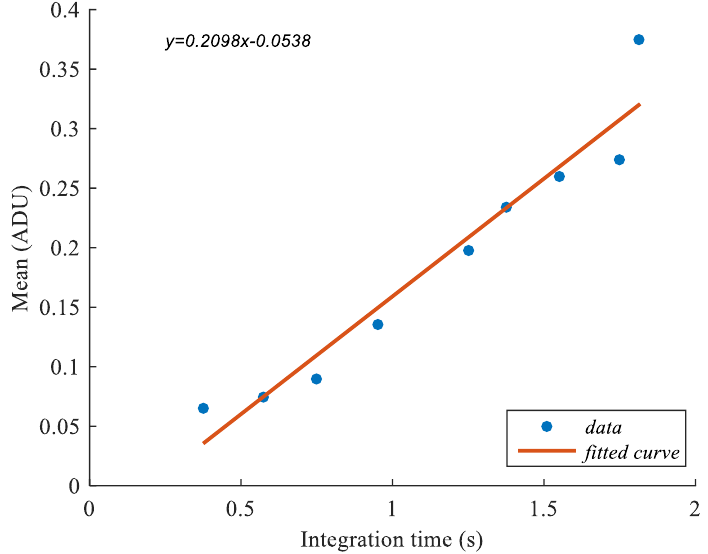
Figure 4. Mean values of each set of measurements in different integration times. In Figure 4, the slope of the linear fit indicates the dark current: 0.2098 ADU/s. This value can be converted to electrons/s, giving 1.095 e − /s. The dark noise N DN is then given